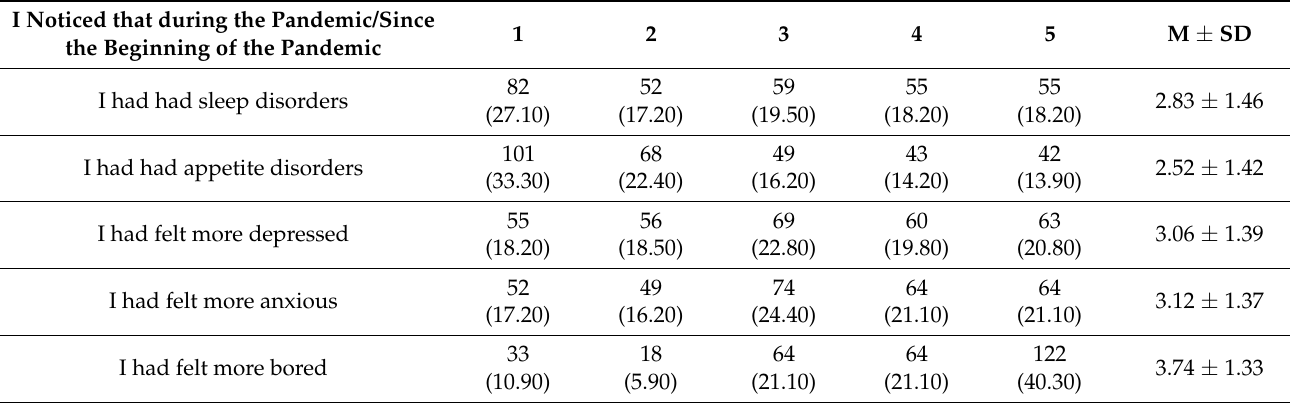
Table 2. Self-rated items regarding psychological status 1